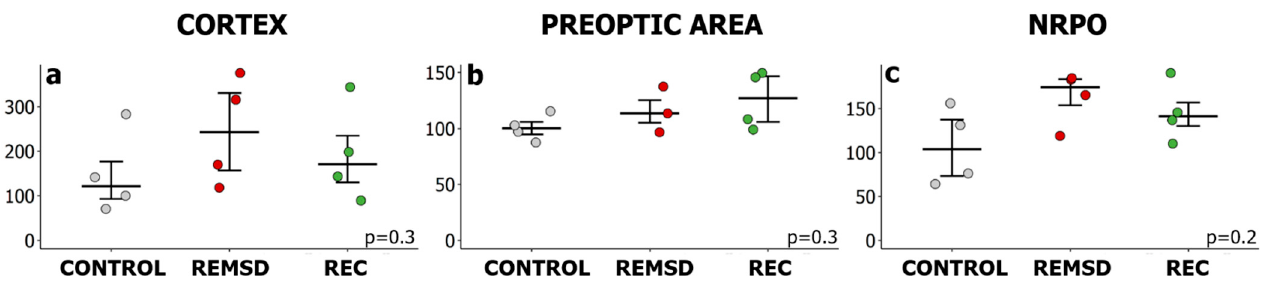
Figure 6. Acute selective REM sleep deprivation (REMSD) does not induce Hspa1 upregulation during the highest rebound of REM sleep in the recovery period (REC). Relative Hspa1 expression level in ( a ) the sensorimotor cortex, ( b ) the preoptic area of the hypothalamus and ( c ) the nucleus reticularis pontis oralis (NRPO) under REMSD conditions. The values were calculated using the 2 −ΔΔ Ct method, where the control group of undisturbed animals was used as the reference, ZT06 (CONTROL, grey). REMSD, red—rats were sacrificed after REMSD, ZT06; REC, green—rats were sacrificed after an episode of REMS 2 h into the recovery period, ZT08. Values are shown as median ± 75/25 percentile. Each dot represents an independent sample (animal). p values were calculated using the Kruskal–Wallis H test.